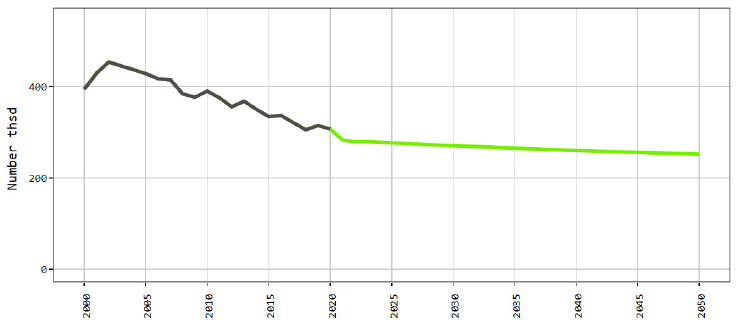
Figure 15. Number of swine in Latvia in 2000–2020, with a projection for 2021–2050, thousands [62].